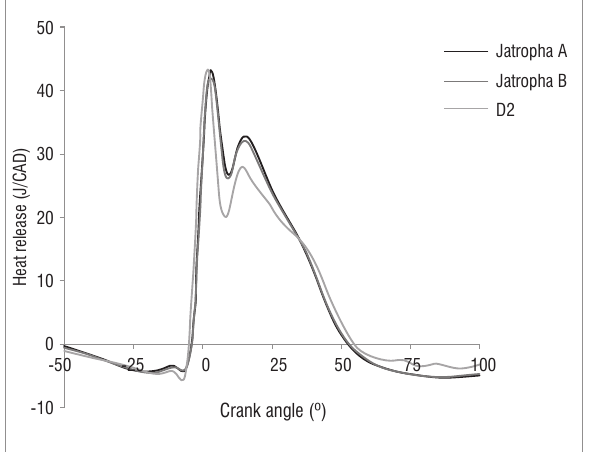
Figure 10: Heat release variation with crank angle at full